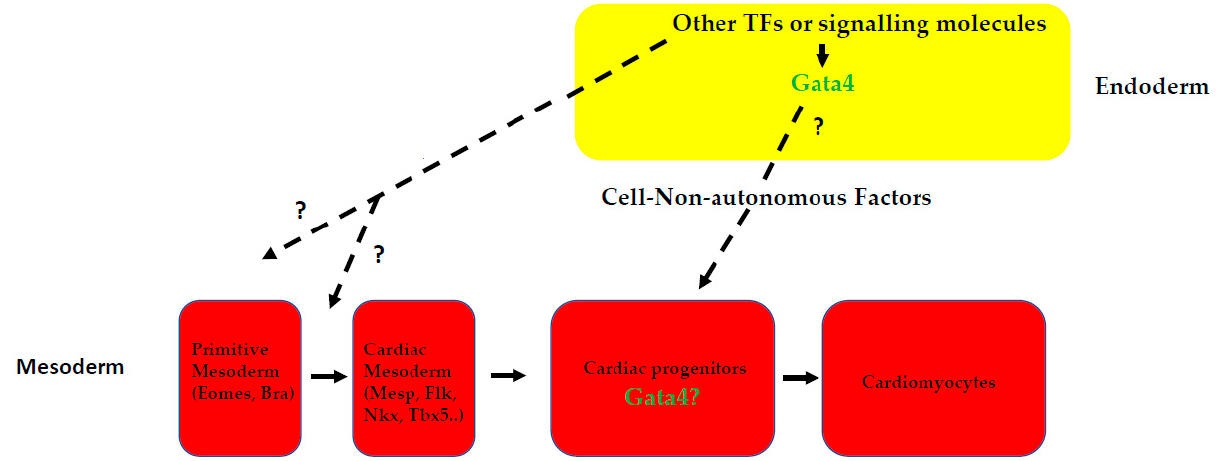
Figure 2. Factors emanating from endoderm induce mesoderm layer formation. Gata4 in endoderm controls a non-cell-autonomous pathway for cardiac myogenesis. Other transcription factors and signalling molecules induce Gata4 in endoderm, which in turn induces secreted molecules that promote cardiac differentiation of the underlying cardiac progenitors to cardiomyocytes. This model did not exclude a direct function of Gata4 in the mesoderm itself to promote cardiac differentiation as depicted by the question mark (?). Abbreviations: Eomes, Eomesodermin; Bra, Brachyury; Mesp, Mesoderm Posterior; Nkx, Nkx gene; Tbx, Tbx gene; Gata4, Gata4 gene.